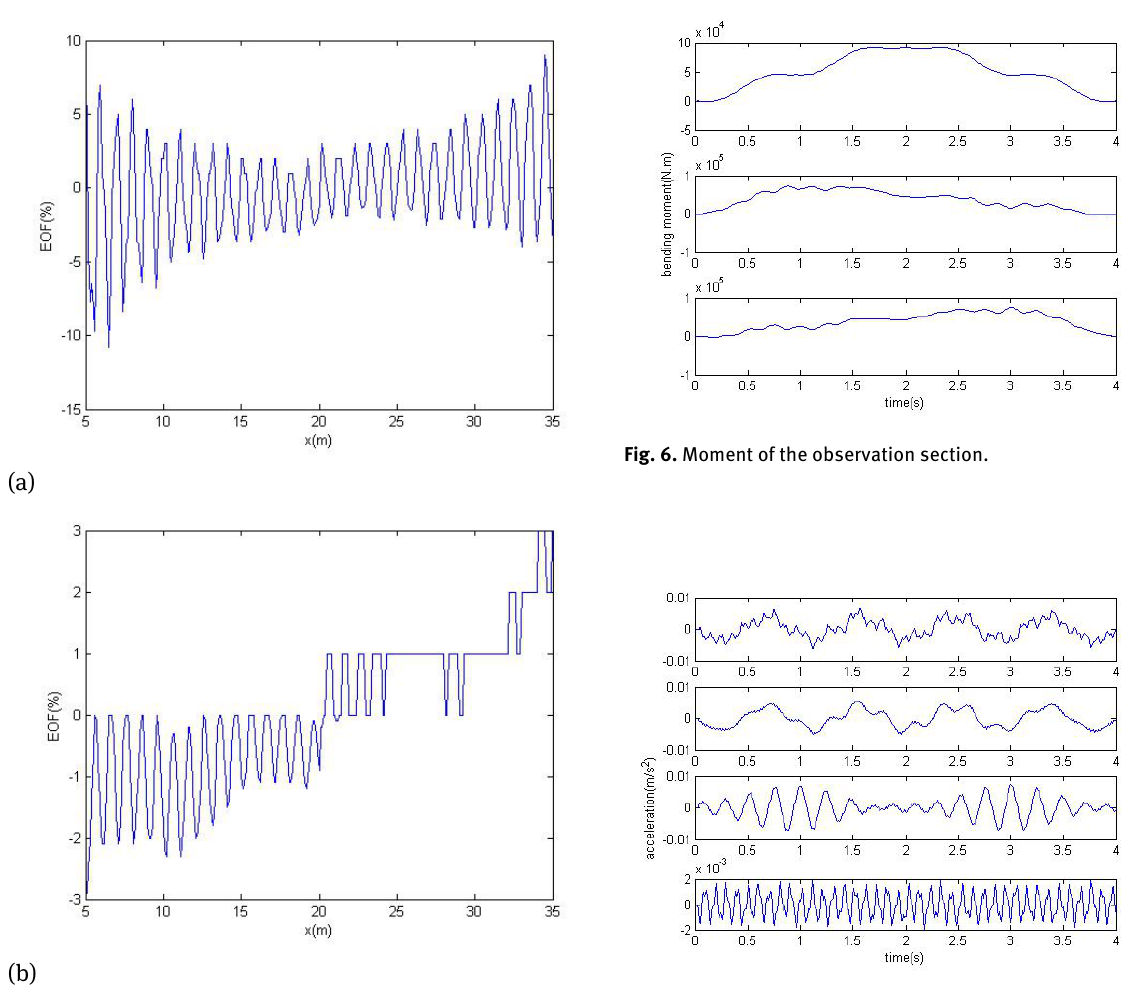
Fig. 7. Acceleration of separated. From Fig. 8 and Fig. 9, the identification results ob- tained from using this method meet well with the actual force even though the force is time varying. In the main domain not near boundary, the inaccuracy is not over 5%, which indicates a very good accuracy comparing with other identification methods. In fact, this method doesn’t have to consider the ill-conditioned matrix coming from matrix singularity, since the identified force is a single one. The single force also features the high compute efficiency of the